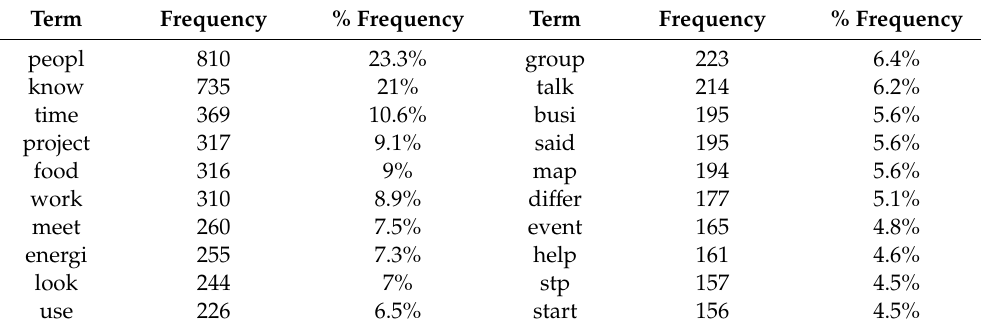
Table 3. Twenty most frequently occurring terms, using TF